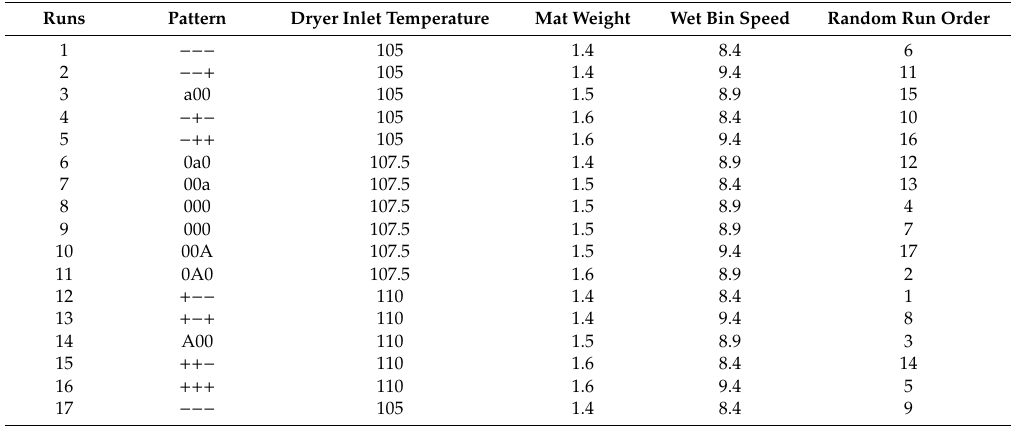
Figure 3. Designed experimental models for MDF and OSB using the outcomes of the boosted tree and random forest models. Table 7. Central composite design for ultimate static load ( n = 17) for 2 k , k = 3 with three center points based on the results of the RT for